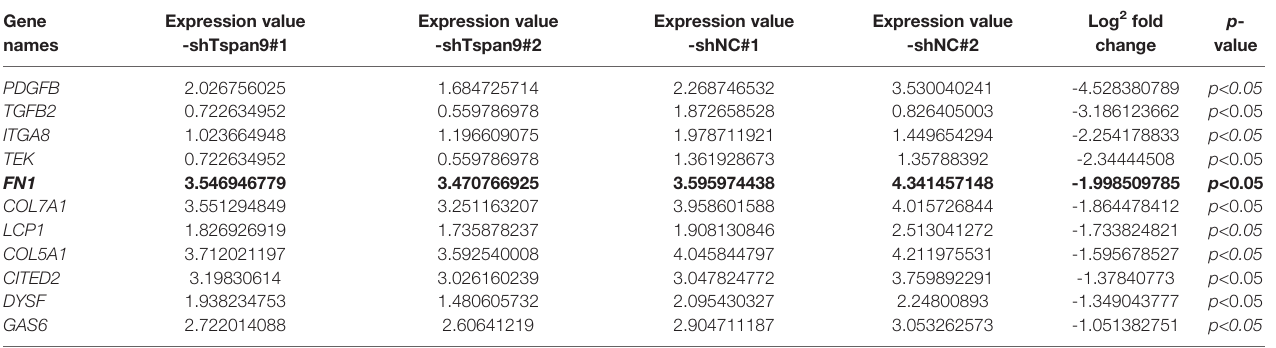
TABLE 2 | Eleven of 82 differential genes enriched in certain cancer metastasis-related GO processes (regulation of cell adhesion and extracellular matrix organization) based on